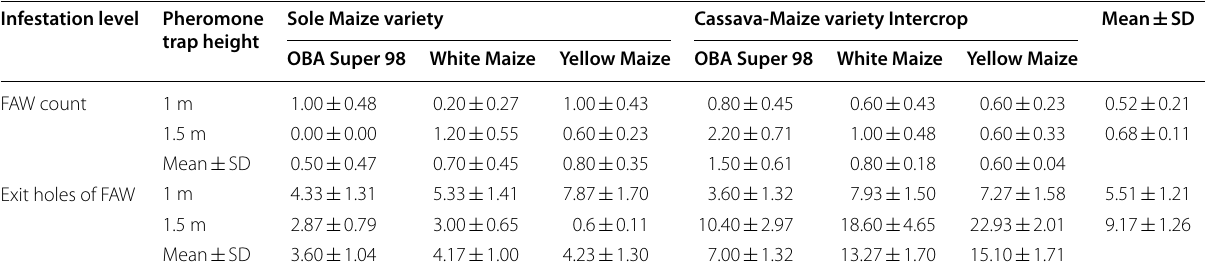
Table 1 Fall Army Worm counts and Exit holes in Maize-Cassava intercrop cultivated in Niger Delta Region using two pheromone traps Infestation level Pheromone trap height